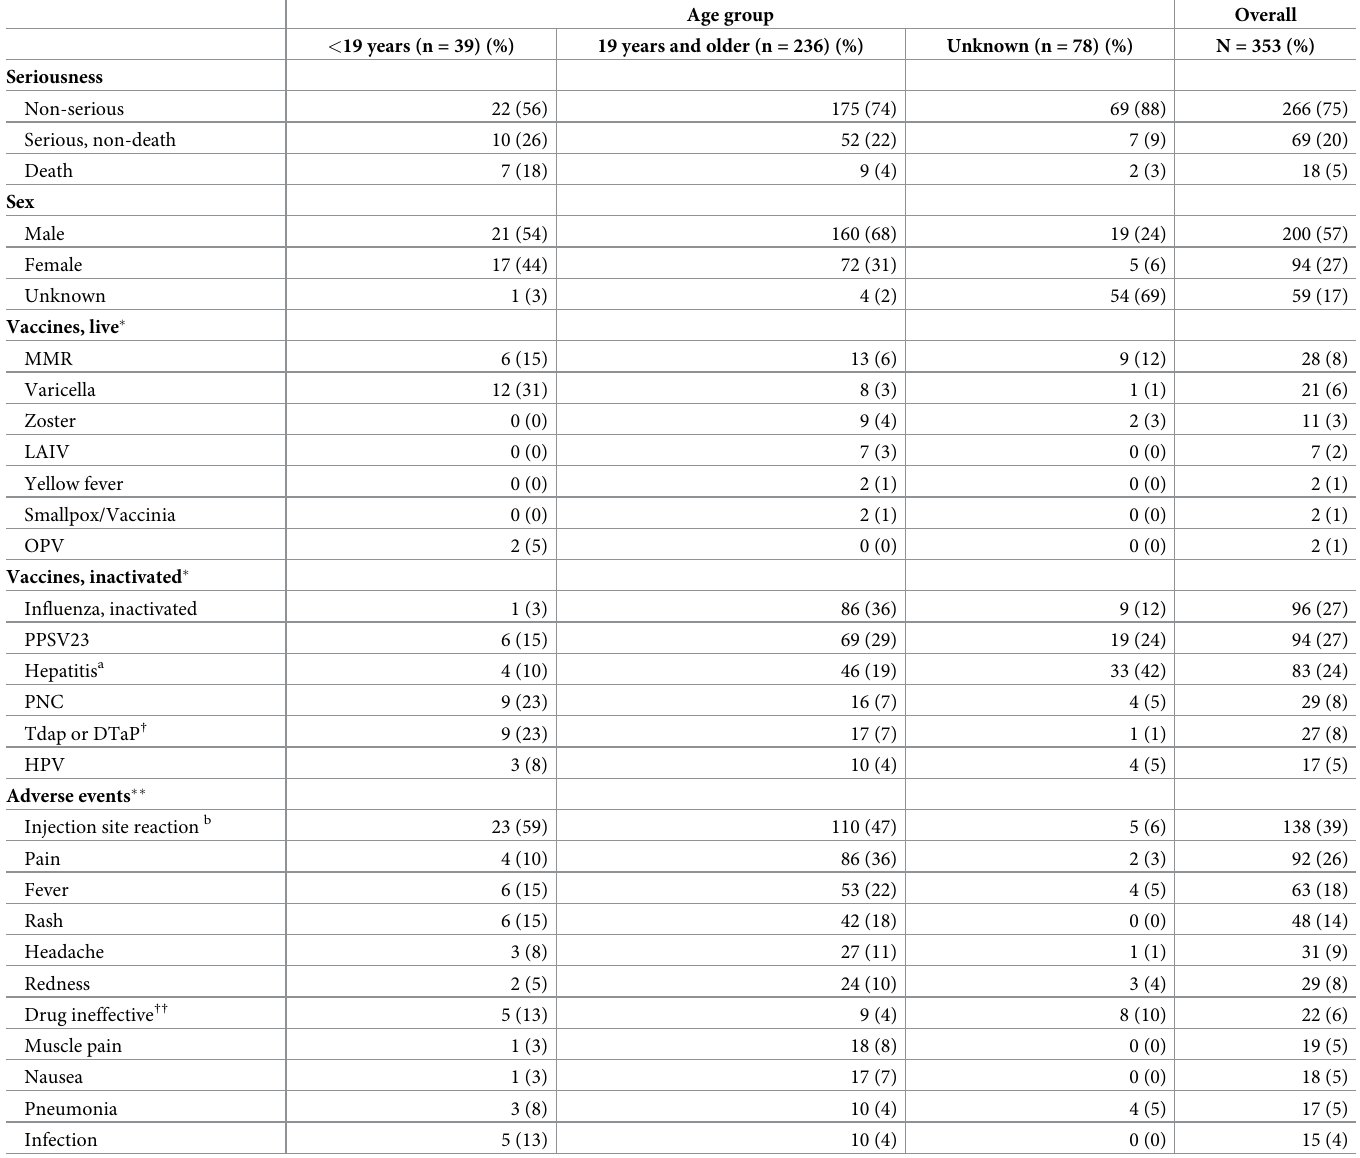
Table 1. Characteristics of reports to VAERS among HIV-positive persons,